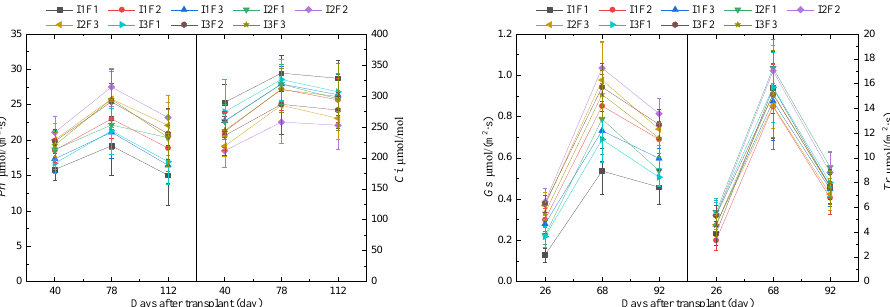
Figure 3. Effect of integrated water and fertilizer on photosynthetic characteristics of tomato leaves using moistube irrigation of greenhouse tomatoes. Note: I represents the irrigation amount, F represents the fertilizer amount.